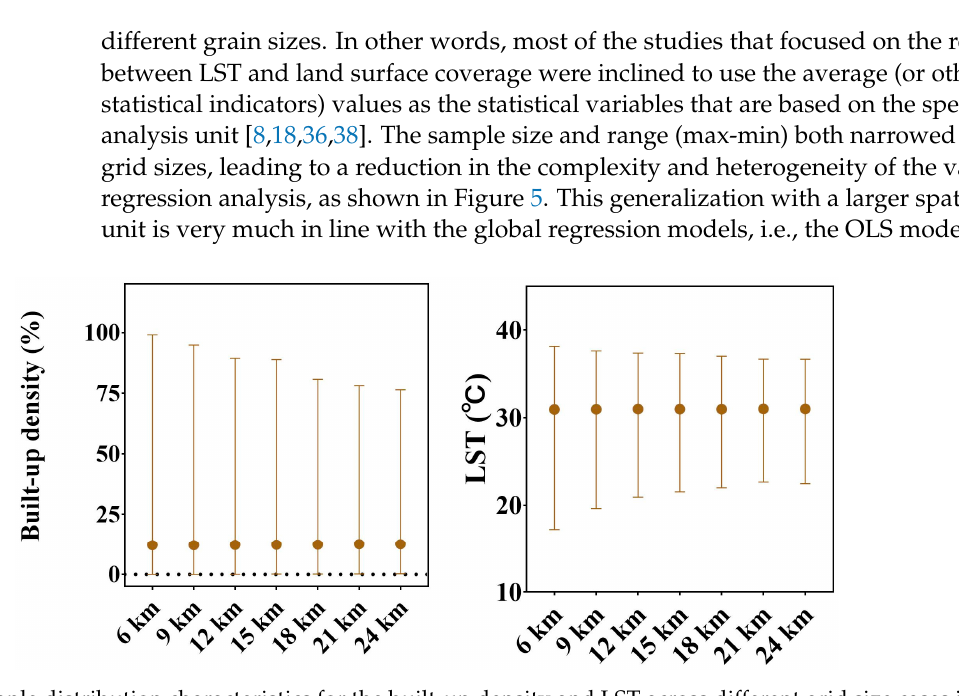
Figure 5. The sample distribution characteristics for the built-up density and LST across different grid size cases in 2015. The dots represent the average value, and the error bars represent the minimum and maximum